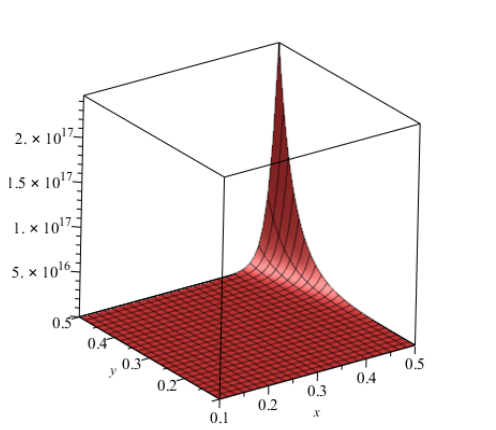
Figure 5: Graphical Representation of M-polynomial of hex-derive network HDN 2( n